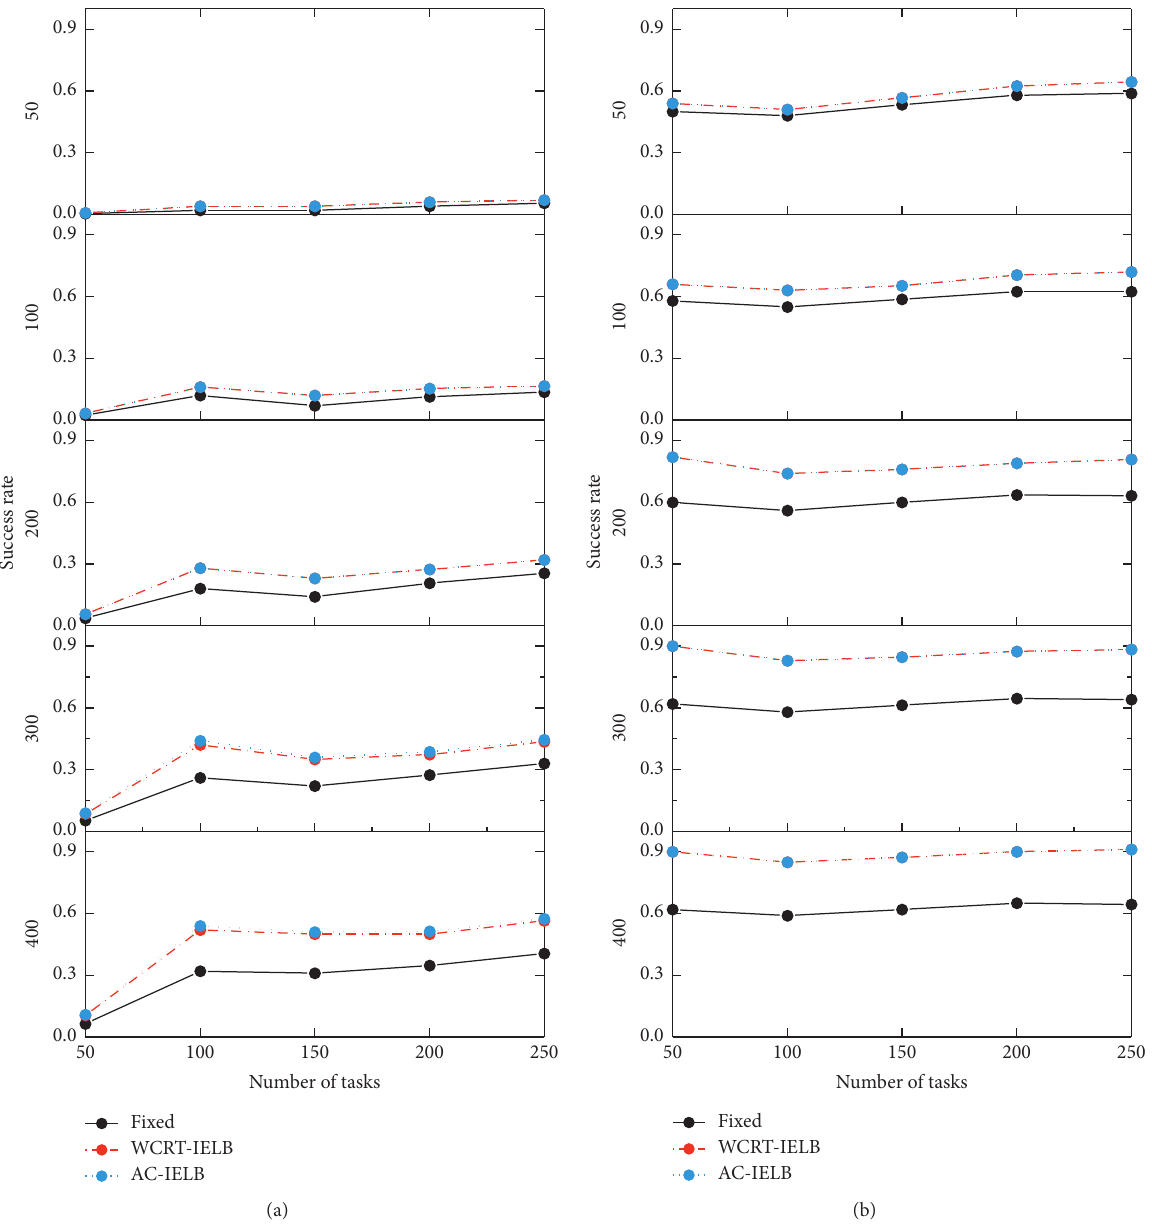
Figure 7: Success rate with a battery capacity of 50, 100, 200, 300, and 400. (a) ALAP scheduling algorithm. (b) ASAP scheduling